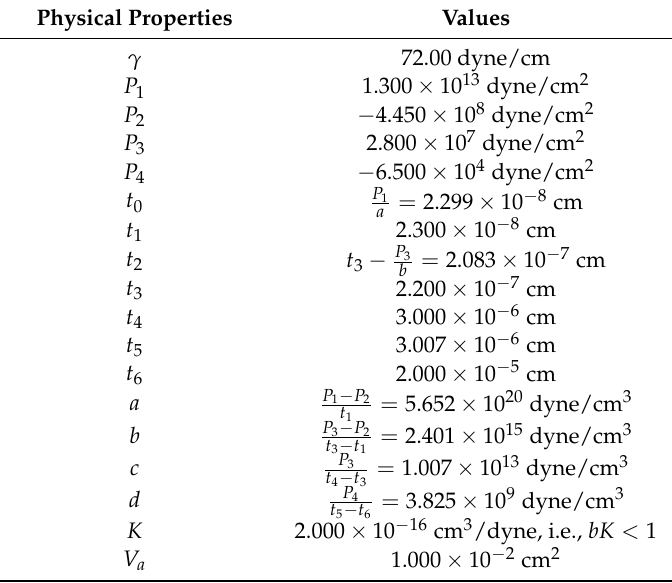
Table 2. Properties of disjoining/conjoining pressure isotherm for advancing/receding contact angles